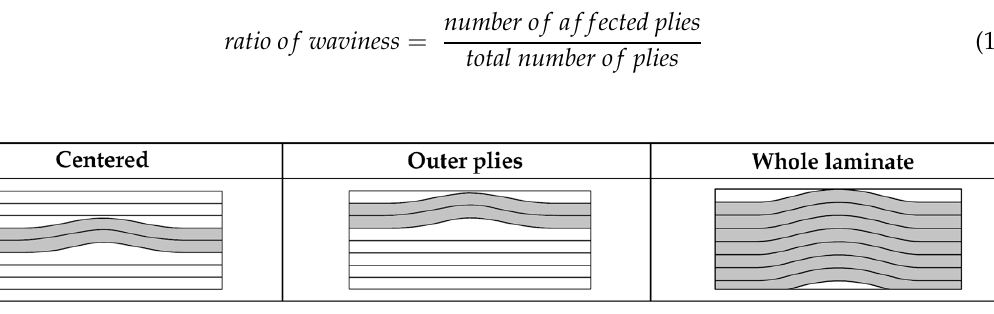
Figure 33. Waves at continuous vs. non-continuous plies.